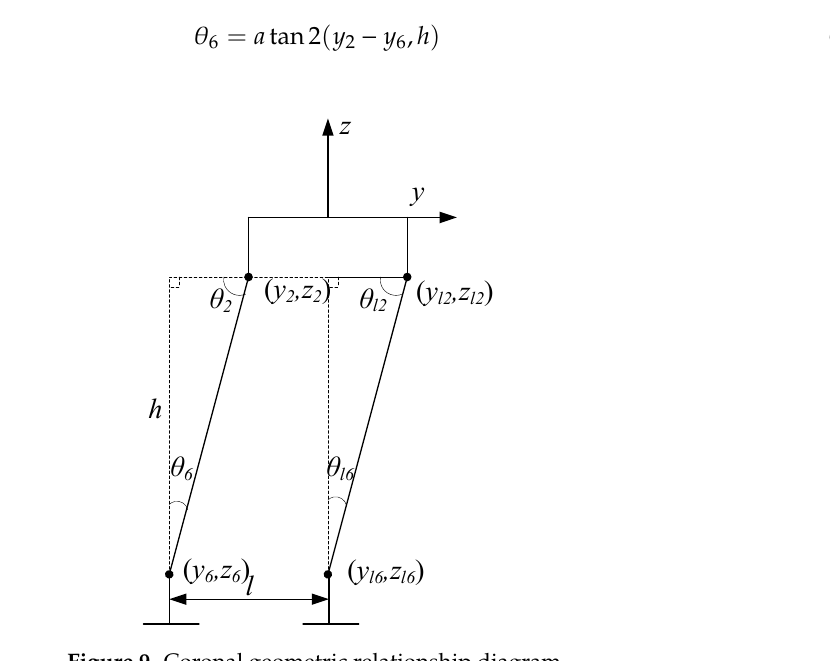
Figure 9. Coronal geometric relationship diagram.